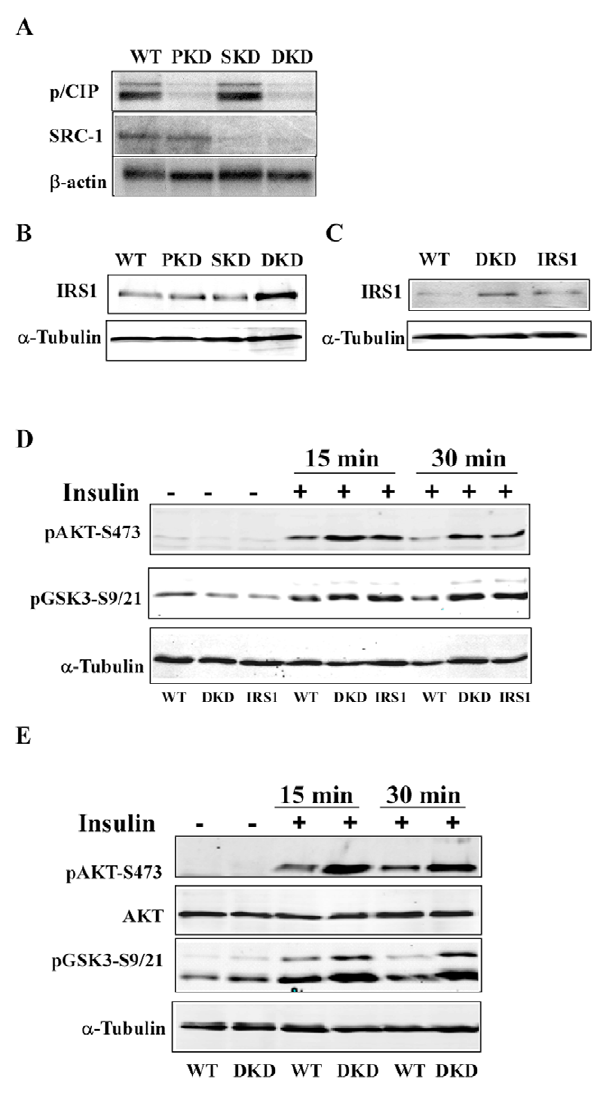
Figure 3. Knockdown of p/CIP and SRC-1 in two cell lines leads to increased IRS1 levels and enhanced insulin signaling. A. Lentiviral shRNA constructs of p/CIP, SRC-1, or both were used to stably knockdown endogenous levels of these coactivators in the F442A fibroblast cell line. 10 m g of total RNAs were used in Northern blot analyses to detect p/CIP and SRC-1 levels. A b -actin probe served as loading control. B. 50 m g total proteins of cell lysates from p/CIP knockdown (PKD), SRC-1 knockdown (SKD), wild-type, and double knockdown (DKD) were resolved by SDS-PAGE gel prior to immunoblot analyses. IRS1 protein levels were significantly increased in the DKD cell line, based on the a -tubulin loading control. C. Immunoblot analyses with stable p/CIP/SRC-1 DKD and IRS1 overexpression F442A cell lines. D. Serum starved F442A cell lines were stimulated for 15 or 30 min with 200 nM insulin, and immunoblot analyses were performed with the